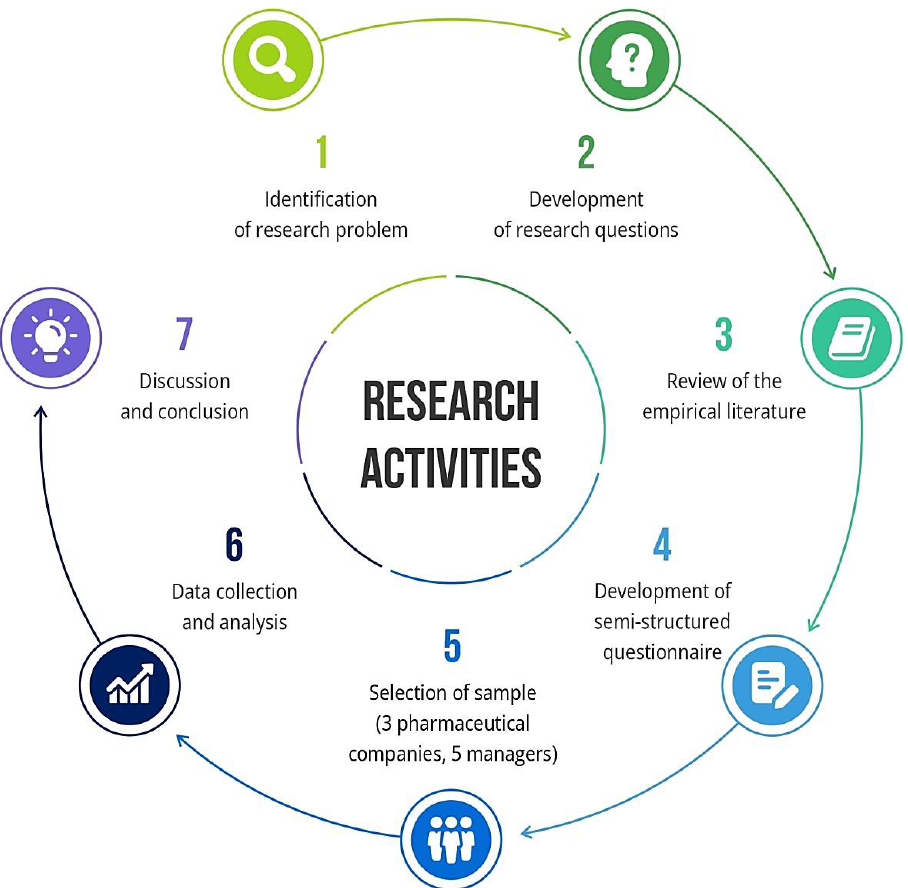
Figure 3. Qualitative analysis